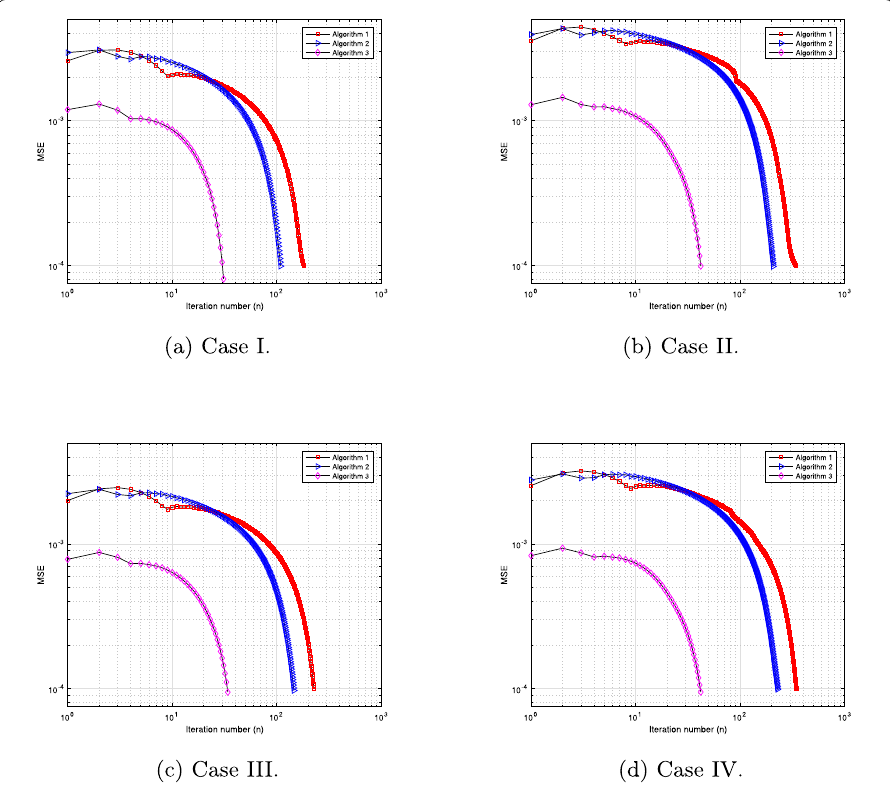
Figure 12 Convergence behavior of MSE for Example